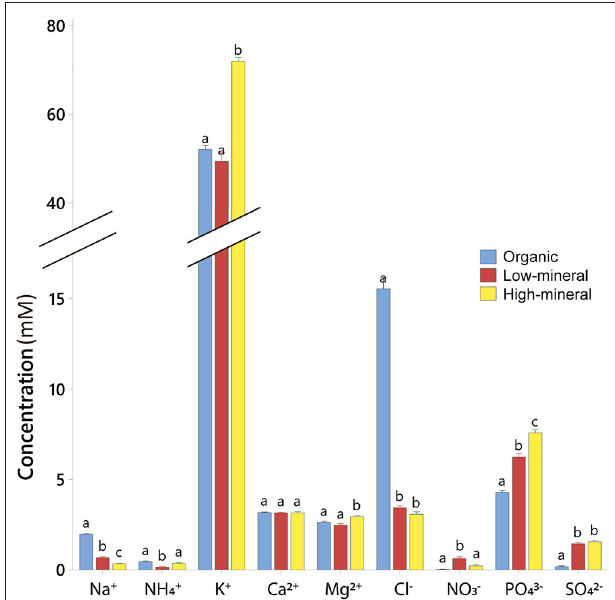
FIGURE 4 | Ionic composition of tomato fruits harvested from plants cultivated with different fertilizers. Mean values ± SD are shown. Different letters indicate statistically significant differences at p = 0.05, n =